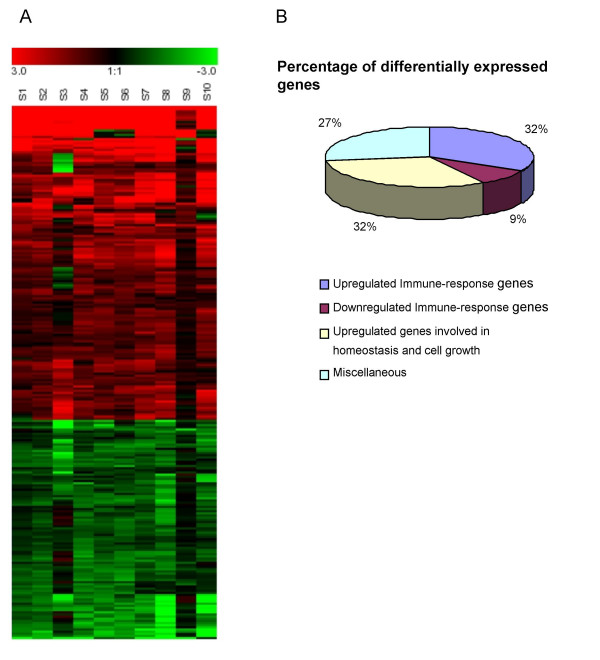
Clustering and distribution of differentially expressed genes. A. Hierarchical clustering of gene expression data from PBMCs from 10 SARS patients showing different classes of gene expression profiles. Each row represents a separate gene and each column a separate SARS patient. 248 genes have been selected for this analysis which is described in methods. The expression index for each gene (rows) in each sample (column) is indicated by a color code. The color scale ranges from saturated green for log ratios -3.0 and above to saturated red for log ratios 3.0 and above. Red indicates increased gene expression levels, whereas green indicates decreased levels compared with normal samples. B. Pie chart showing the percentage distribution of the differentially expressed genes from the PBMCs of 10 SARS patients.